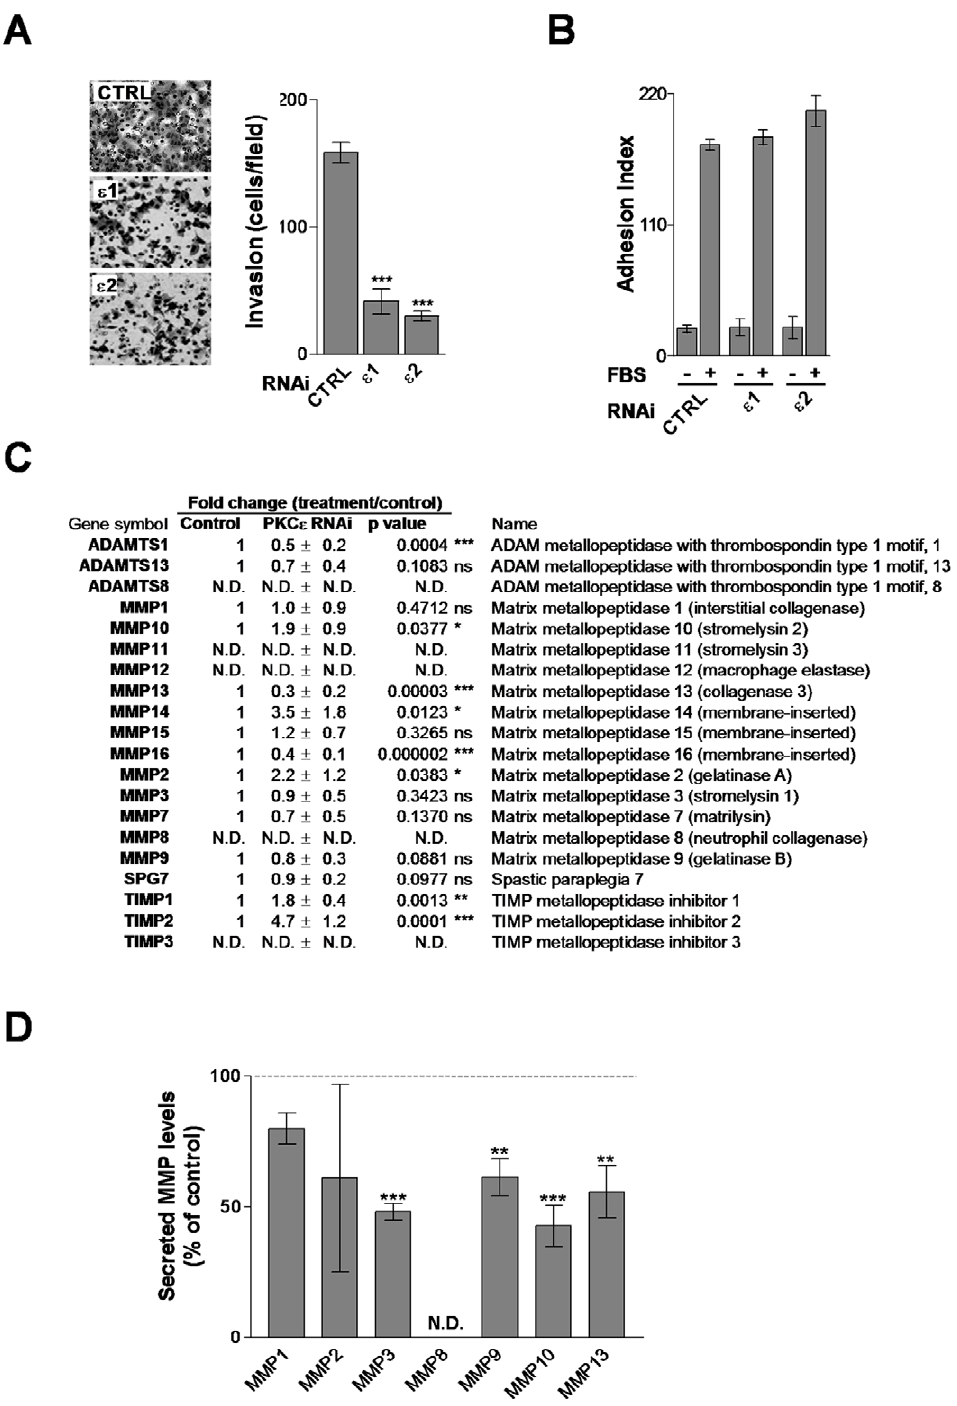
Figure 6. PKC e modulates invasion and ECM-genes in A549 cells. A. A549 cells were transfected with RNAi for either PKC e ( e 1 and e 2) or control ( CTRL ) and 2 days later serum-starved for additional 24 h. Cells were then seeded in Boyden chambers with Matrigel-coated membranes. Invasion was quantified 24 h later. Left , representative micrographs. Right , quantification of invasive cells. Data are represented as mean 6 S.E.M. (n=3). ***, p , 0.001. B. Adhesion to Matrigel-coated plates was determined 24 h after seeding. Data are represented as mean 6 S.E.M. (n=3). C. Analysis of proteases and inhibitors of proteases by qPCR in control or PKC e -depleted cells. Results are expressed as mean 6 S.E.M. (n=4). D. Detection of ECM proteases secreted to conditioned medium (CM) from control or PKC e -depleted A549 cells. Quantification of MMP levels by densitometry is represented as mean 6 S.E.M. (n=3). **, p , 0.01; ***, p , 0.001. N.D. , not-determined.